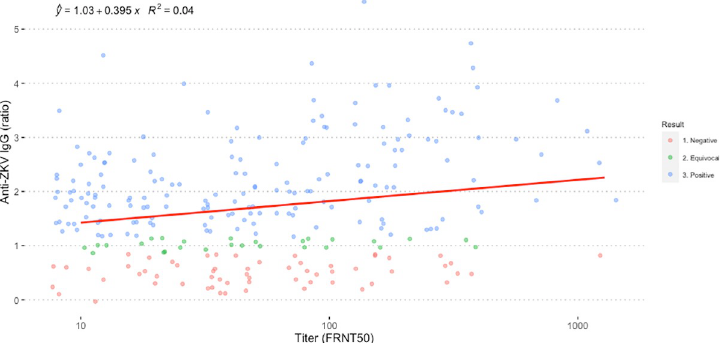
Fig 3. The correlation of ZKV-nAb titer and ZKV-specific IgG. The correlation graph and equation were generated using ggplot2 package in R. nAb titer (x-axis) and ZKV-specific IgG (y-axis).